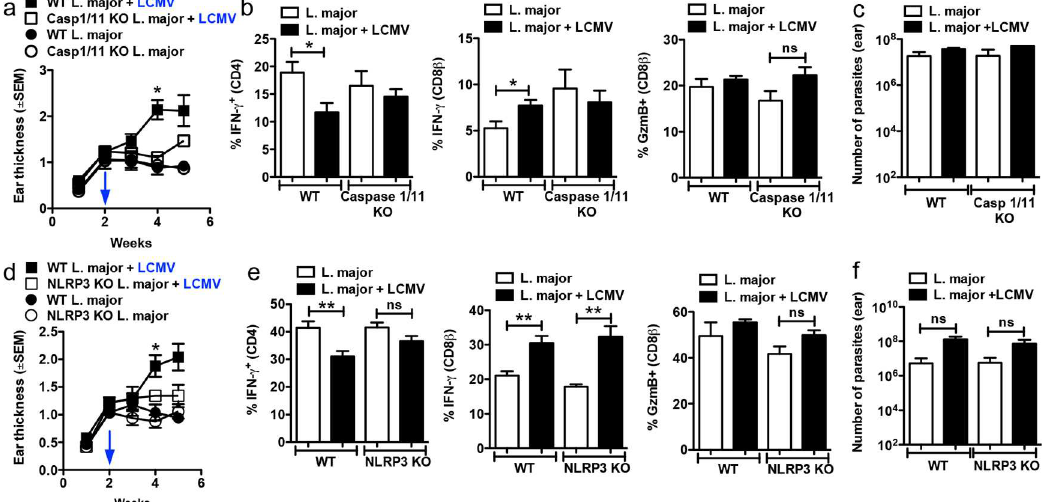
Fig 3. Immunopathology caused by CD8 T cells is dependent on the NLRP3 inflammasome. WT, caspase-1/11-/- or NLRP3-/- C57BL/6 mice were infected with L . major in the ear, and 2 weeks later mice were co-infectedwith 2 × 10 5 PFU of LCMV Armstrong strain by i.p. injection; (a and d) ear thickness was assessedweekly. Five weeks post infection with L . major , mice were euthanized and the lesionswere digested and used for flow cytometric analysisof intracellular IFN- γ and GzmB on (b and e) CD4 T cells or CD8 T cells. (c and f) Number of parasitesin the skin was determined at 5 weeks post infectionwith L . major . Graphs are data from 2 to 3 independentexperiments (n = 5 mice per group) with similar results. ** p < 0 .